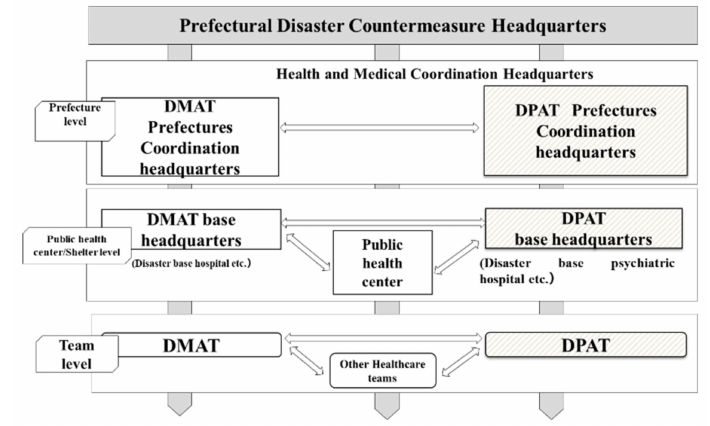
Figure 3. The Disaster Medical Assistance Team (DMAT) operational